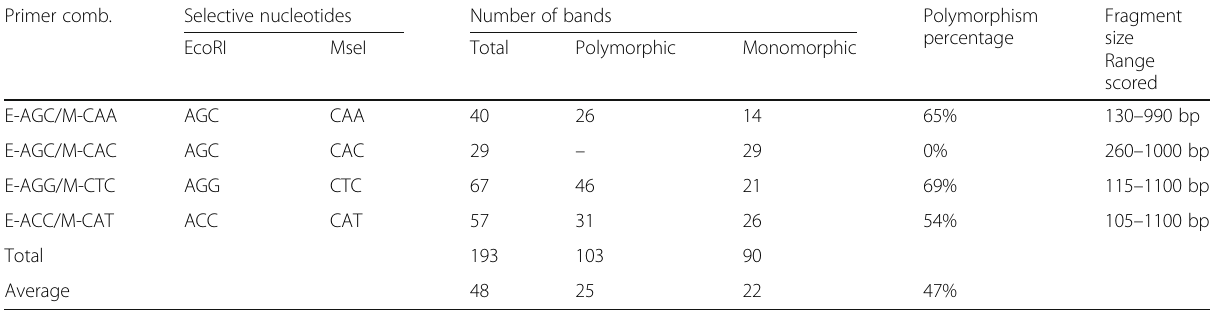
Table 2 AFLP primer combinations, selective nucleotides, number of polymorphic bands, total bands, polymorphism percentage, and fragment size range in Origanum species Primer comb.